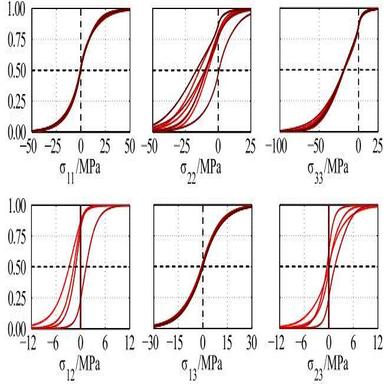
Cumulative probability of the stress components at 33 = 0.001 for all investigated crystallographic orientations (indicated by color). Each cumulative probability of ij contains the complete set of ij values from all four honeycomb structures. Figure adopted from with permission from Elsevier.